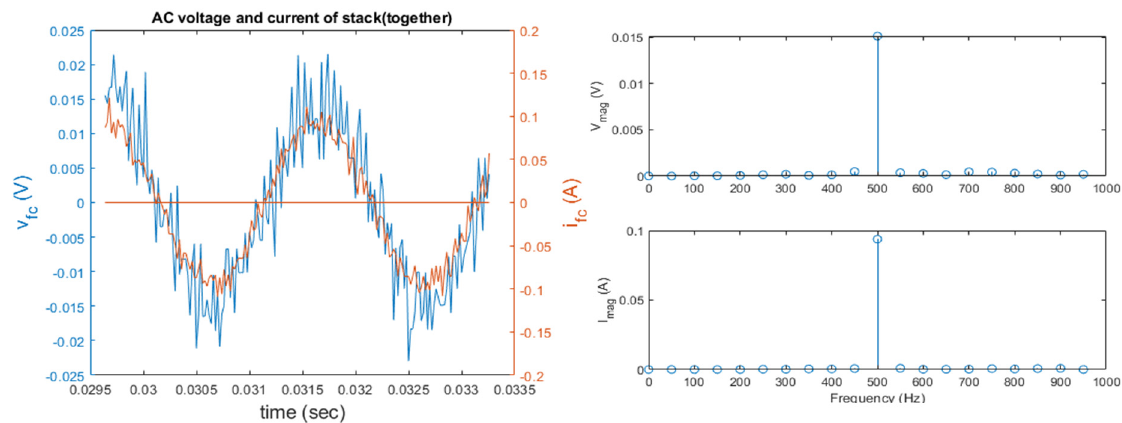
Figure 13. Waveform and spectrum of AC component voltage and current (500 Hz) .